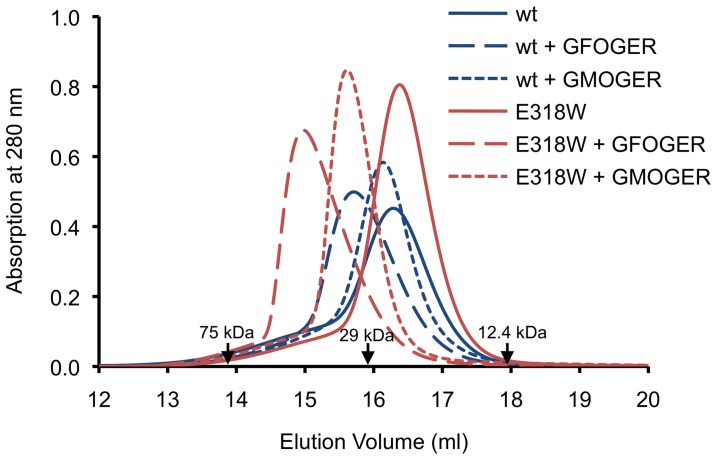
Analytical size exclusion chromatography of integrin α2 I domain-collagen complexes.The complexes were formed by incubating wild-type α2 I and α2 I E318W with the indicated peptides (peptide:I domain ≥2:1) and analysed on a Superdex 200 column. The peptides do not contribute to the absorbance at 280 nm. The elution volumes of three molecular mass standards are indicated by labelled arrows. The molecular mass of α2 I E318W is 25.1 kDa. The masses of the trimeric collagen peptides range from 5.7 to 5.9 kDa. The peaks at 14.9 and 15.6–15.7 ml are interpreted to contain, respectively, I domain-collagen complexes of 2:1 and 1:1 stoichiometry (see text).